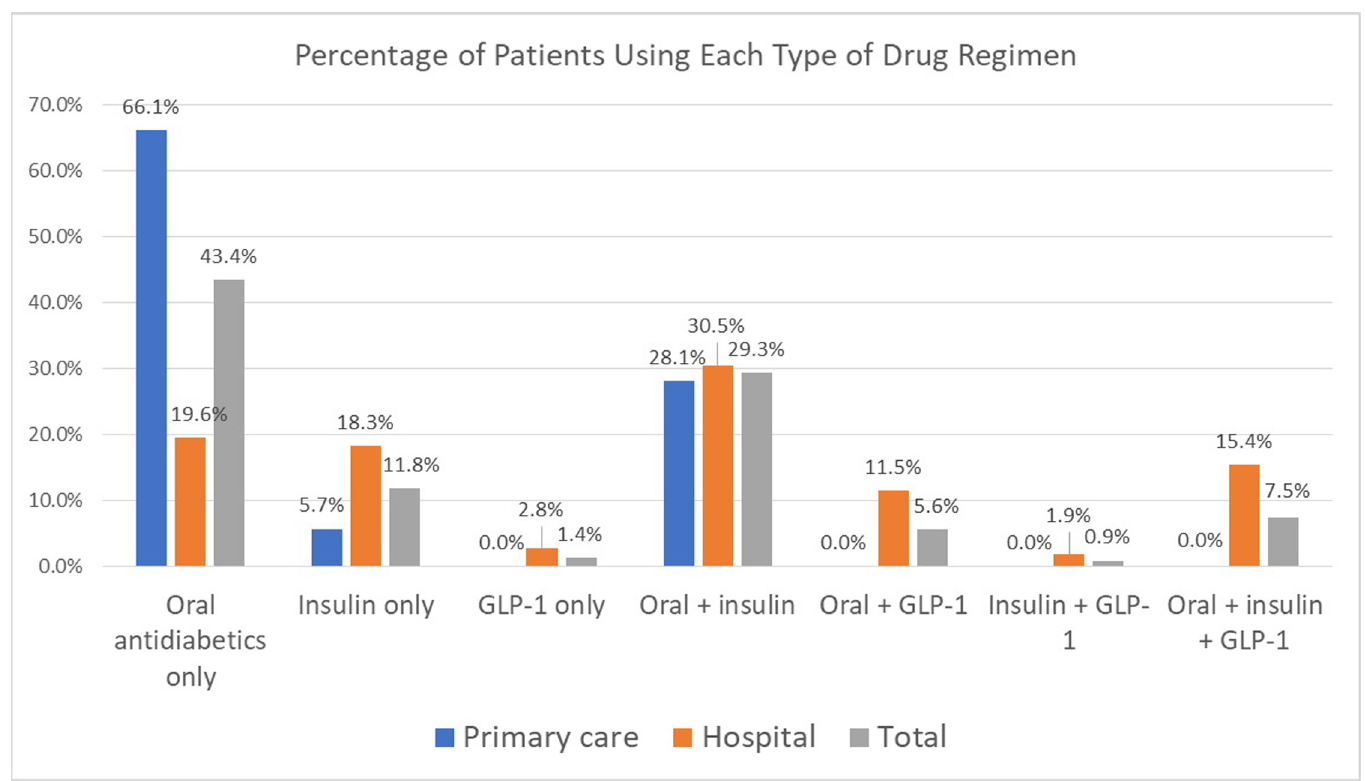
Fig 2. Frequency of different types of drug regimens utilization by facility type in Kuwait.